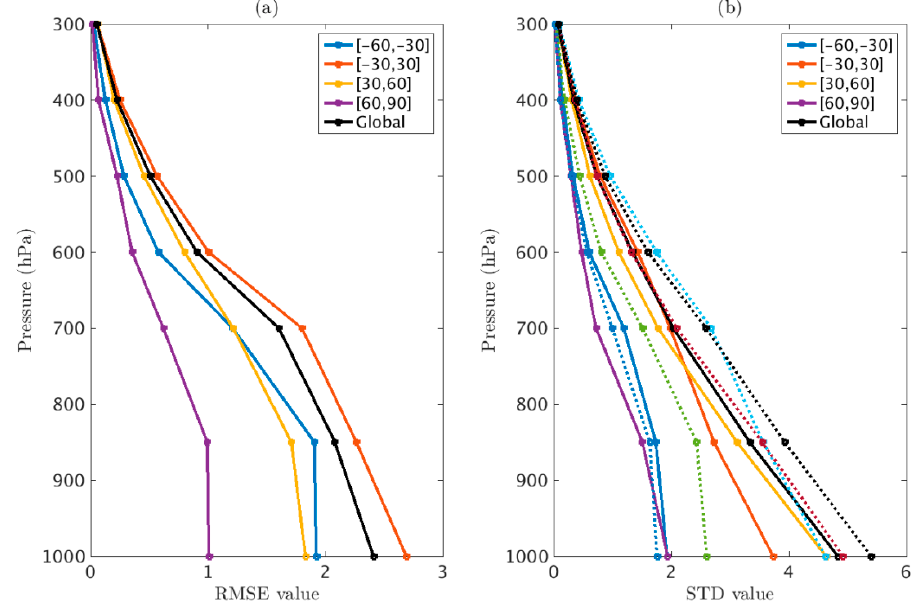
Figure 5. HIRS derived specific humidity (g/kg) compared to 2011–2012 RS92 observations for global and latitude bands for ( a ) RMSE and ( b ) STD (solid lines for HIRS and dashed lines for radiosonde values).